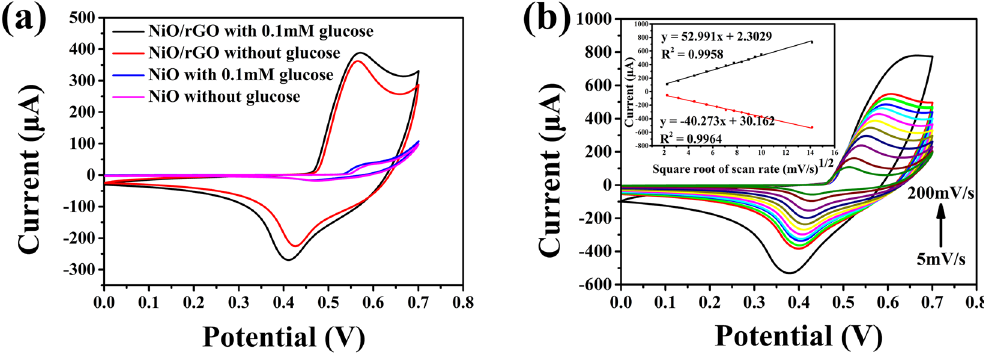
Figure 7. ( a ) CVs of NiO hollow sphere/GCE, NiO hollow sphere/rGO/GCE in 0.1 M NaOH solution in the absence and presence of 0.1 mM glucose. ( b ) CVs of the NiO/rGO/GCE in 0.1 M NaOH in the presence of 0.1 mM glucose at different scan rates. Inset shows the plot of the electrocatalytic current of glucose vs. v 1/2 .